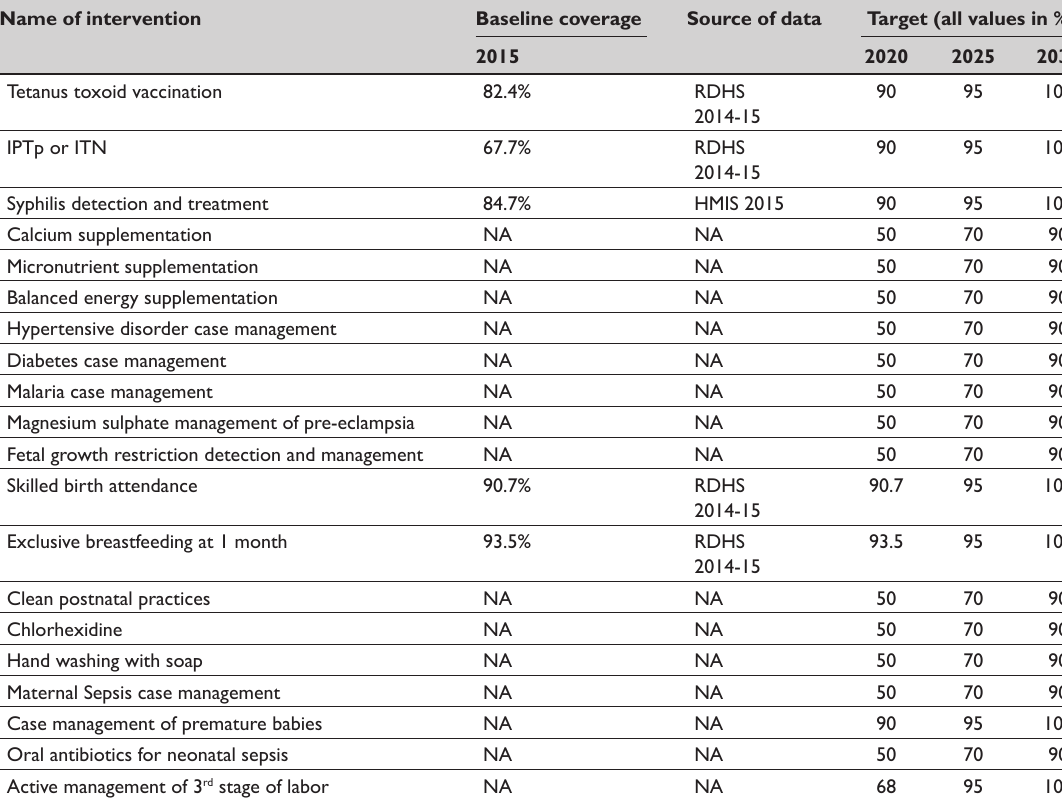
Table 7: Baseline coverage and target for the year 2020, 2025 and